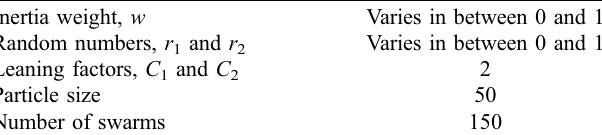
Table 2. Input parameters to